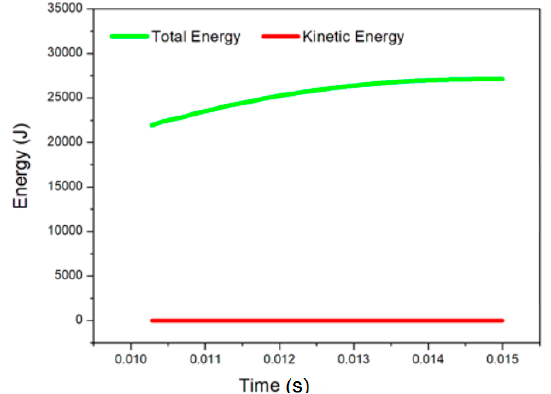
Figure 4. Comparison between kinetic energy and total energy indication.